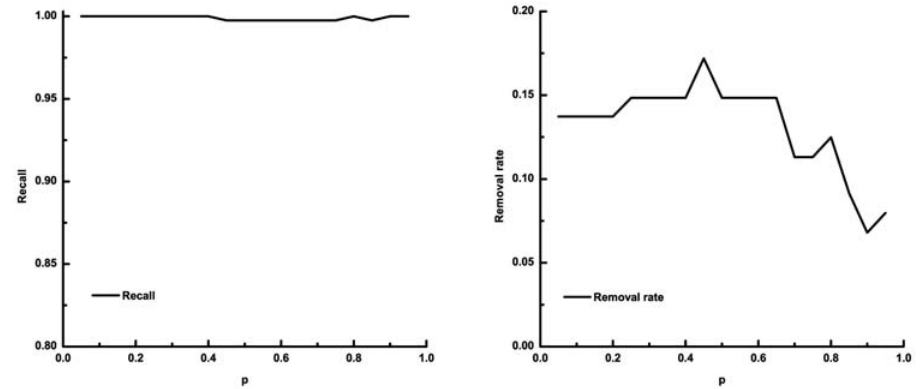
Fig 6. The recall and removal rate of prediction on Esrrb-miRNA relationships using protein-coding gene related positive data sets of transcription factor Esrrb and five-fold cross validation. In each panel, the x-axis denotes the parameter p of SVMlight, it ranges from 0.05 to 0.95 with a step size of 0.05. The y-axis denotes the recall (left panel) and the removal rate (right panel) of the prediction,